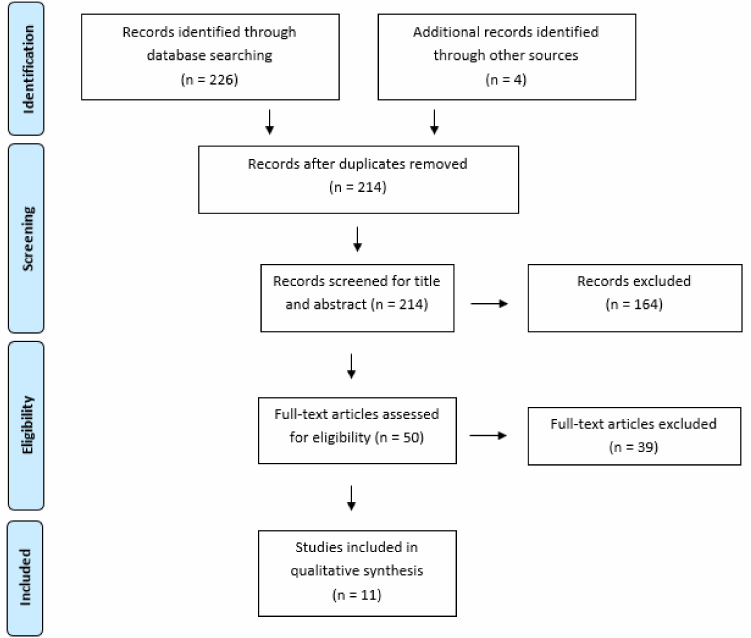
Figure 1. Prisma Flow